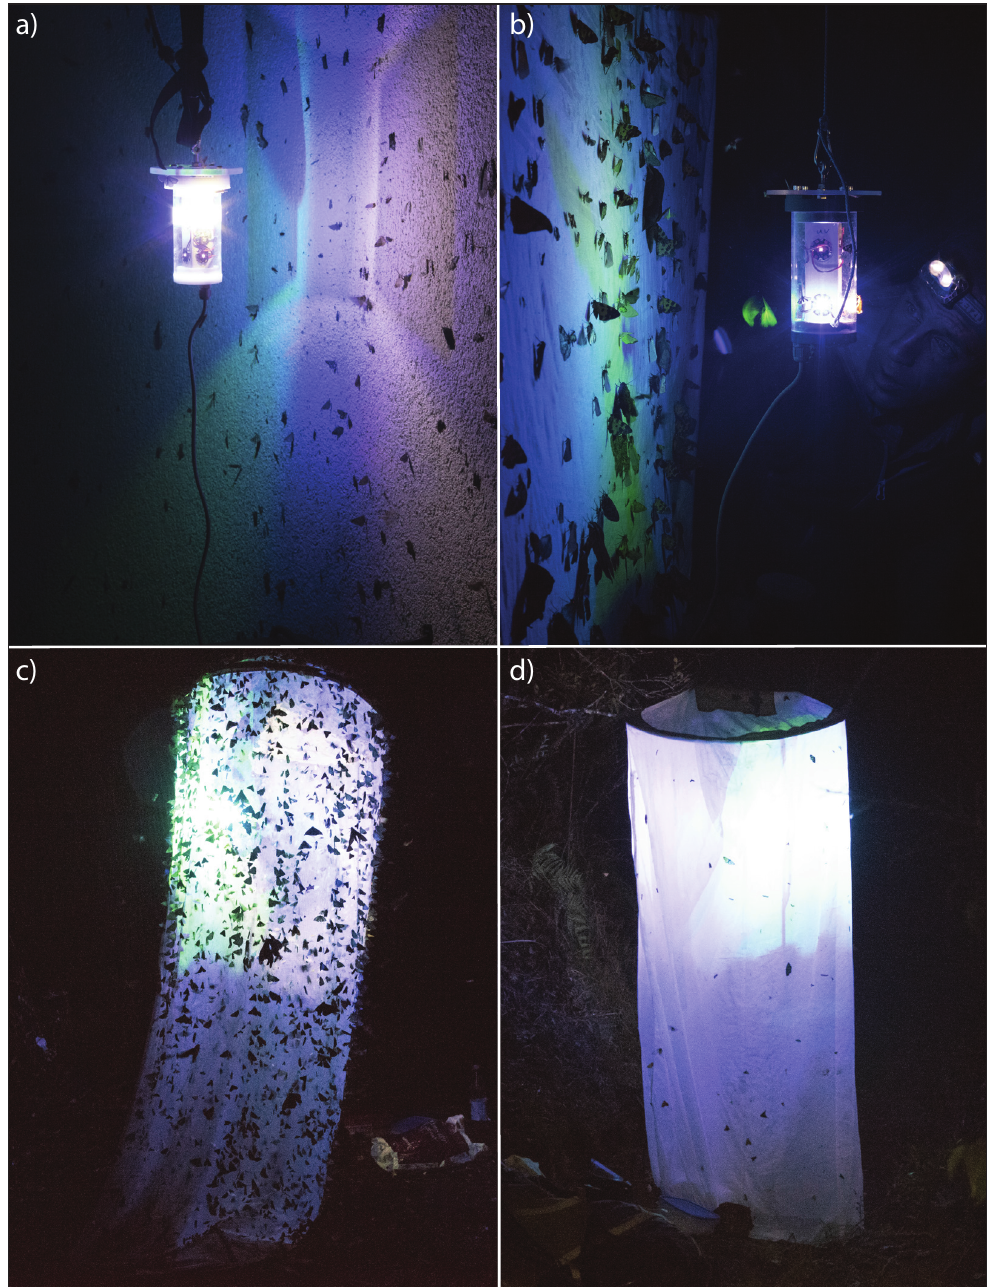
Figure 7. LED lamp used in field work. a. Lamp operating in front of a house wall, Oberversant, South Ty- rol, Italy (8.vii.2016). b. Lamp operating in front of a white sheet, Paradise Lodge, Cosñipata valley, Cusco Province, Peru, 1360 m (30.viii.2016). c. Lamp operating in a gauze tower, Cosñipata valley, Peru, 1940 m (3.ix.2016). d. Lamp operating in a gauze tower, near Wayqecha station, Peru, 2890 m